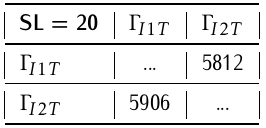
Table 11. Non-unique matching light segments between measurements for trajectory Pites SL=20 ≥ 0 . 7 k With changing baseline between distributions are represented in figure 18.